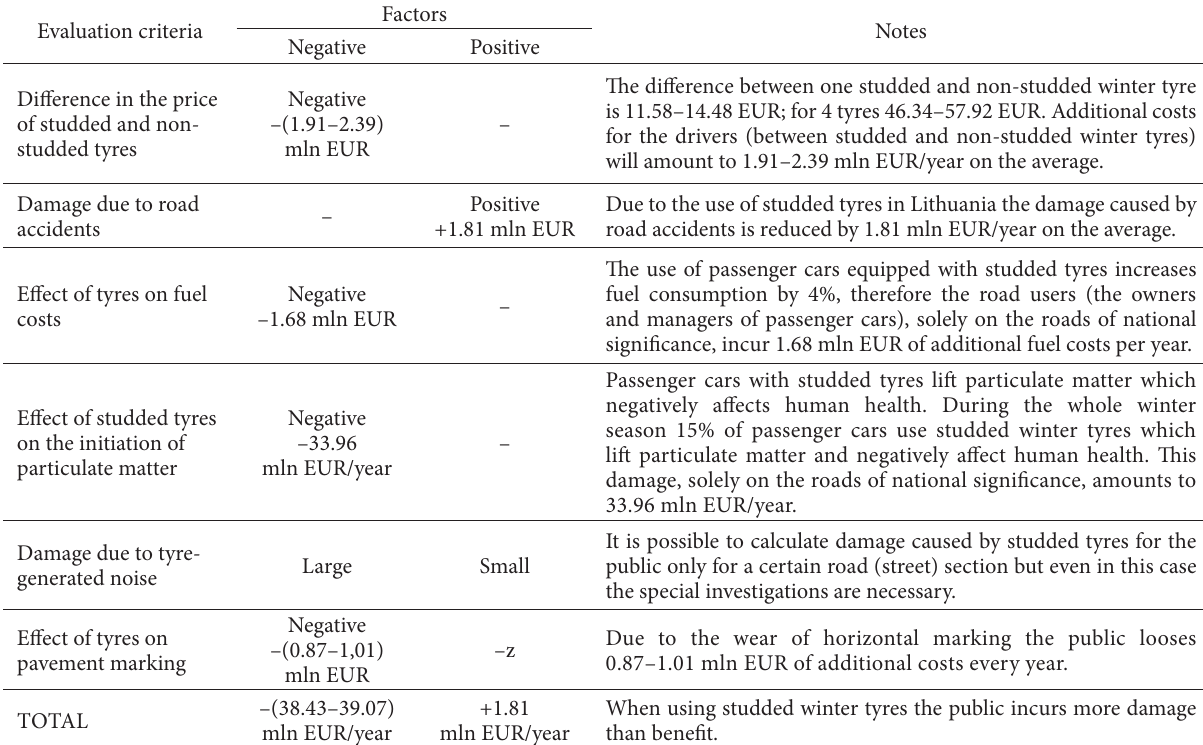
Table 2. Economic evaluation of winter tyres (studded and non-studded)